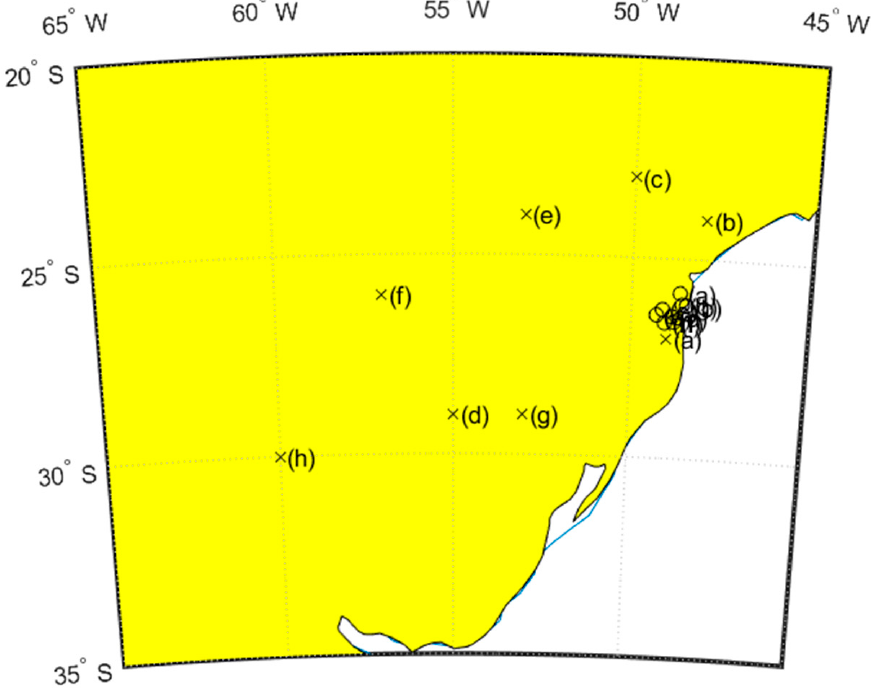
Figure 8. Development of the SAA maximum and centroid.